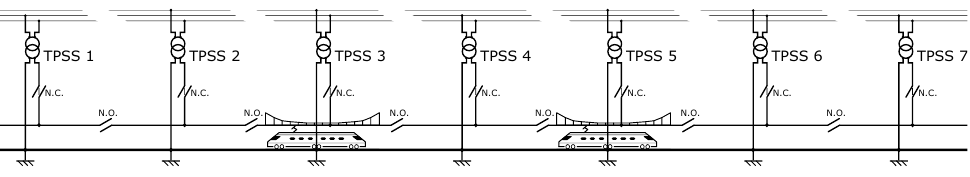
Figure 4. Simplified diagram of case study #1 substations.